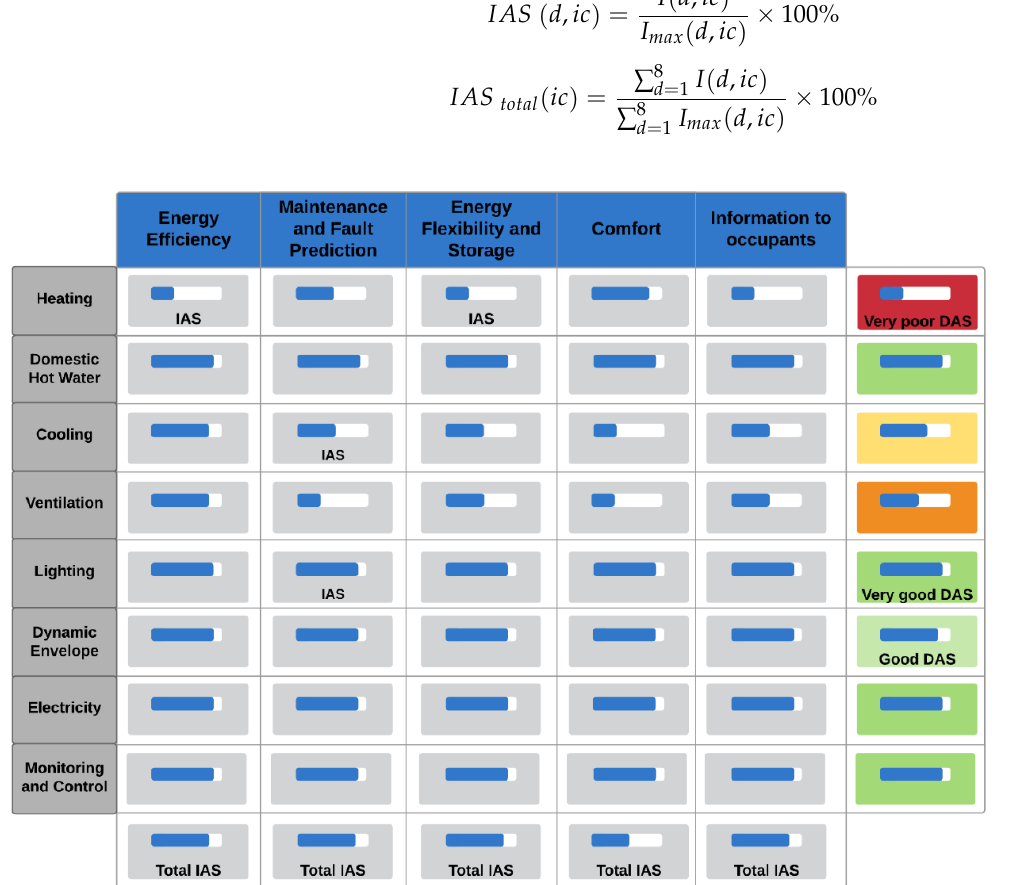
Figure 2. IBACSA evaluation matrix [29].